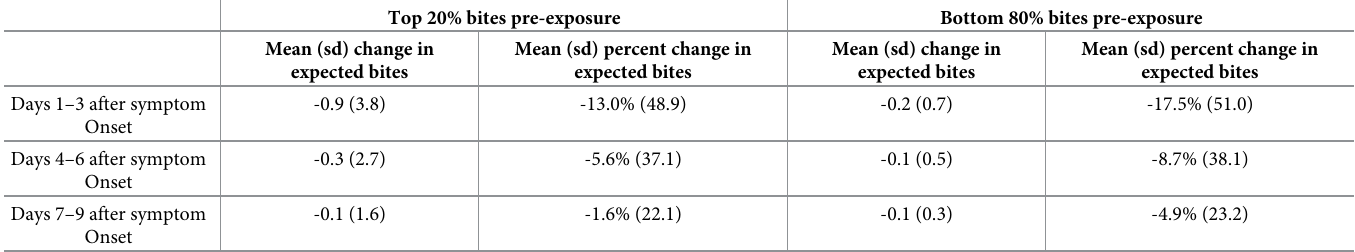
Table 5. Average change in expected mosquito bites for each infectiousness sub-stage when symptomatic mobility changes are occurring (I 2 –I 4 ), separated based on expected bite values pre-exposure, provided as raw number and percent change relative to expected bites